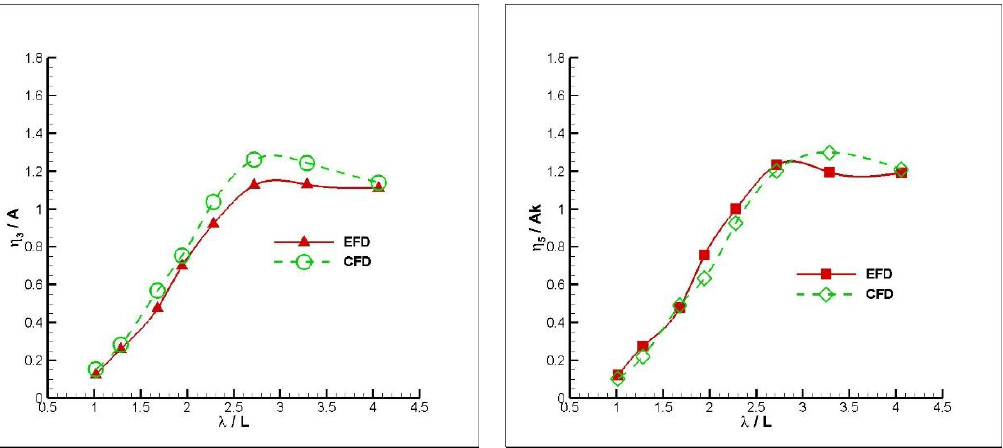
Figure 7. Heave ( left ) and Pitch ( right ) RAOs of the mono hull at Fn B = 2.26.